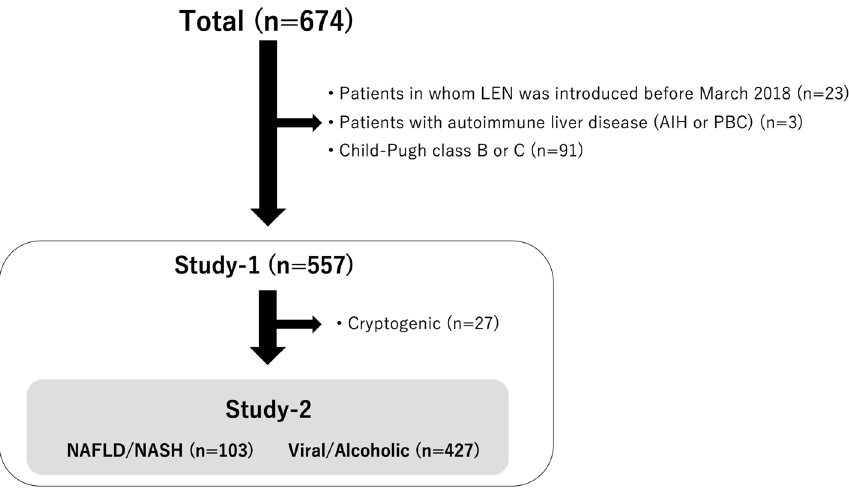
Figure 1. Flow of patient enrollment. LEN lenvatinib, AIH autoimmune hepatitis, PBC primary biliary